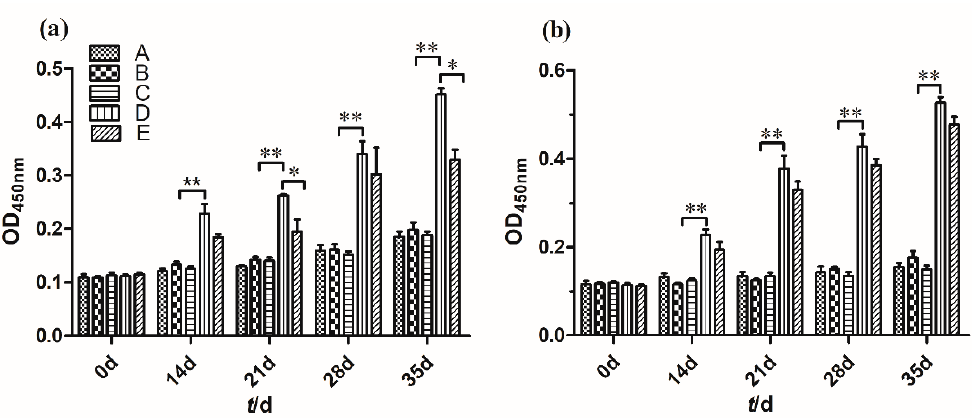
Figure 9. Recombinant B. subtilis BV spores induced specific mucosal and systemic immune